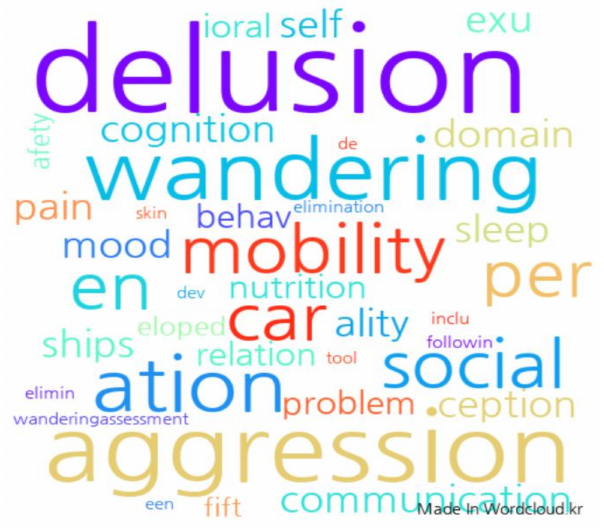
Figure 1. Cloud analysis of the most difficult mental behaviors of dementia patients (Wordclound.kr accessed on 3 December 2020). Table 3. Content analysis of the most necessary education while caring for dementia